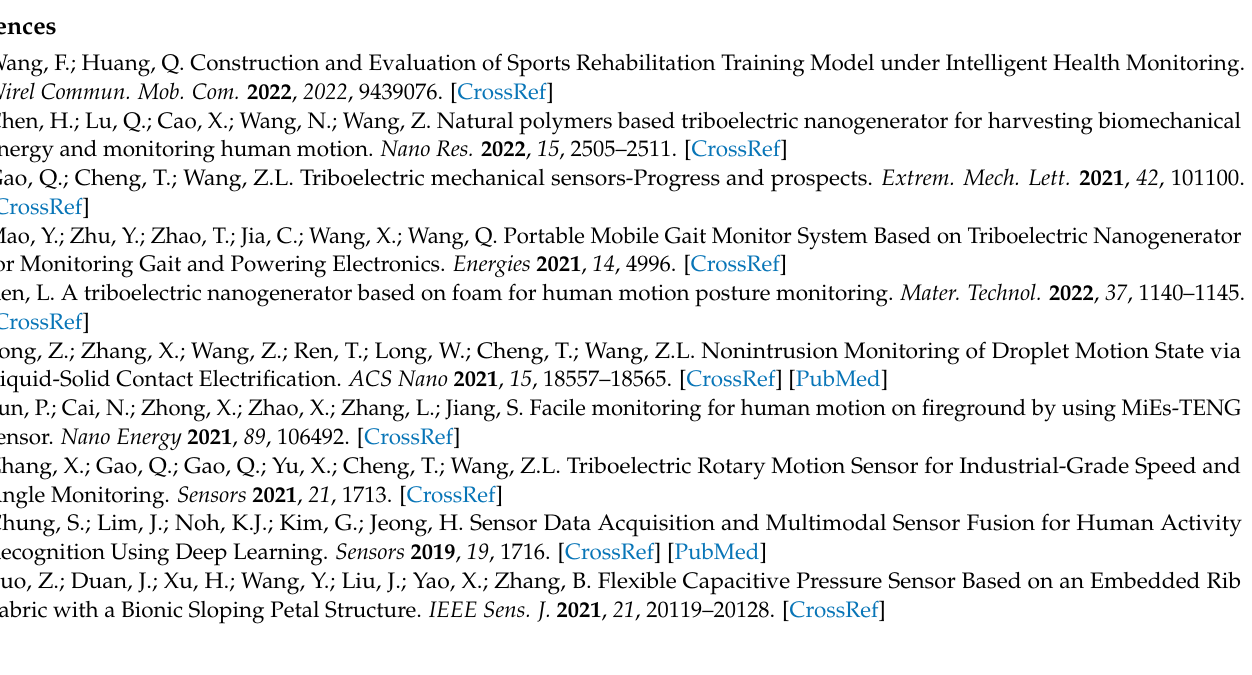
module. Figure S2. The single-line diagram of the AD wireless transmission module. Figure S3. Hydrogel electrode stretchability test. Figure S4. SD-TENG output current at the same angle with different frequencies when the external load is 2 M Ω . Figure S5. The current and response of SD- TENG at different frequencies. Figure S6. SD-TENG output current at the same frequency with different angles when the external load is 2M Ω . Figure S7. Thermal stability test of SD-TENG. Figure S8. The relationship diagram between the output voltage and force of SD-TENG. Figure S9. The durability test of the SD-TENG. Figure S10. The output current of SD-TENG with a load resistance of 10 M Ω . Video S1: The SD-TENG spotlight test; Video S2: The SD-TENG charges the electronic calculator and electronic watch; Video S3: Display of the speed skating land training real-time training assistance